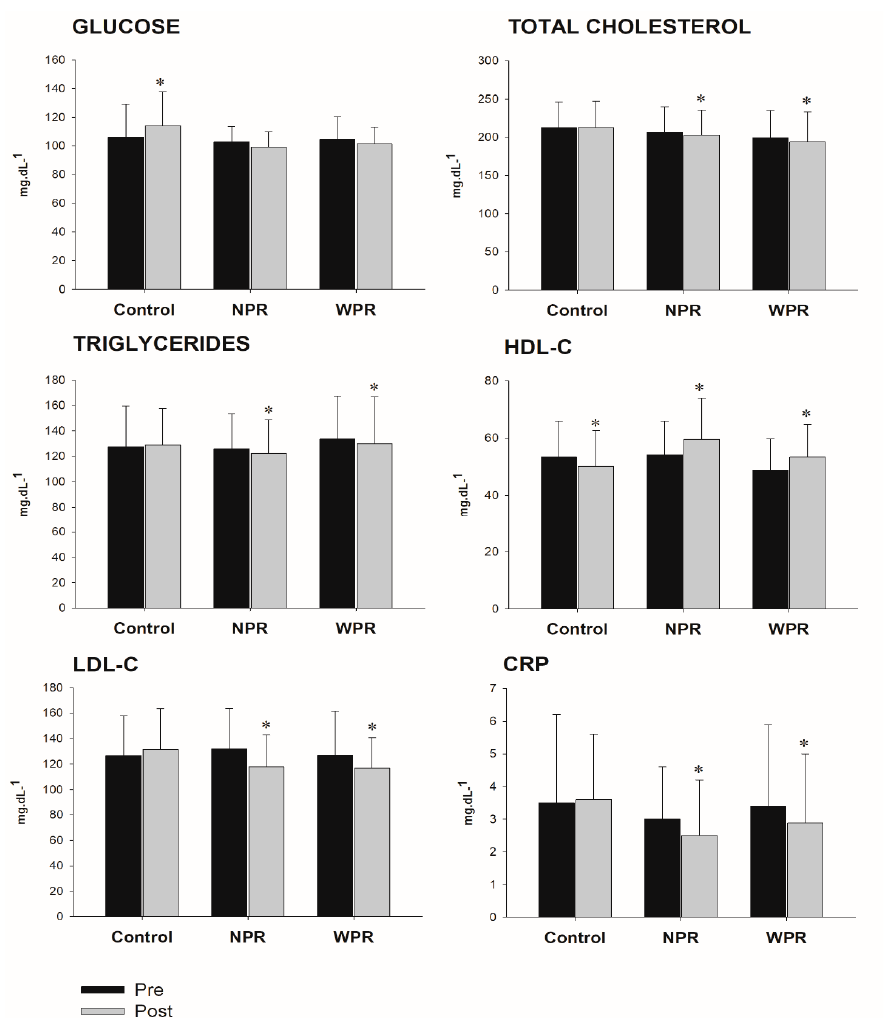
Figure 1. Blood markers at pre- and post-intervention according to groups. NPR = narrow repetition-zone pyramid training; WPR = wide repetition-zone pyramid training; HDL-C = high-density lipoprotein; LDL-C = low-density lipoprotein; CRP = high-sensitivity C-reactive protein. * p < 0.05 vs. pre.